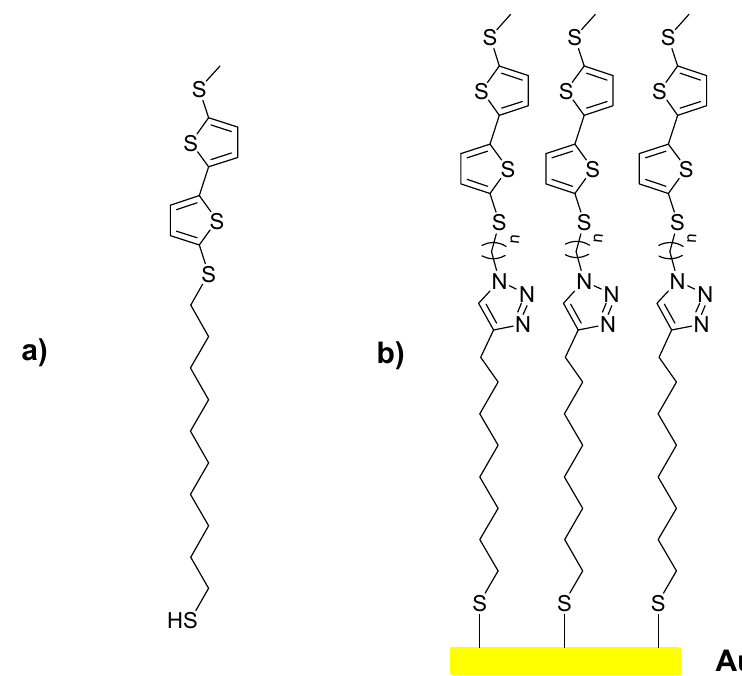
Figure 1. ( a ) 10-(5'-(methylthio)-2,2'-bithiophen-5-ylthio)decane-1-thiol; ( b ) triazolo-5,5'- disubstituted-2,2’-bithiophene immobilized on a gold surface as